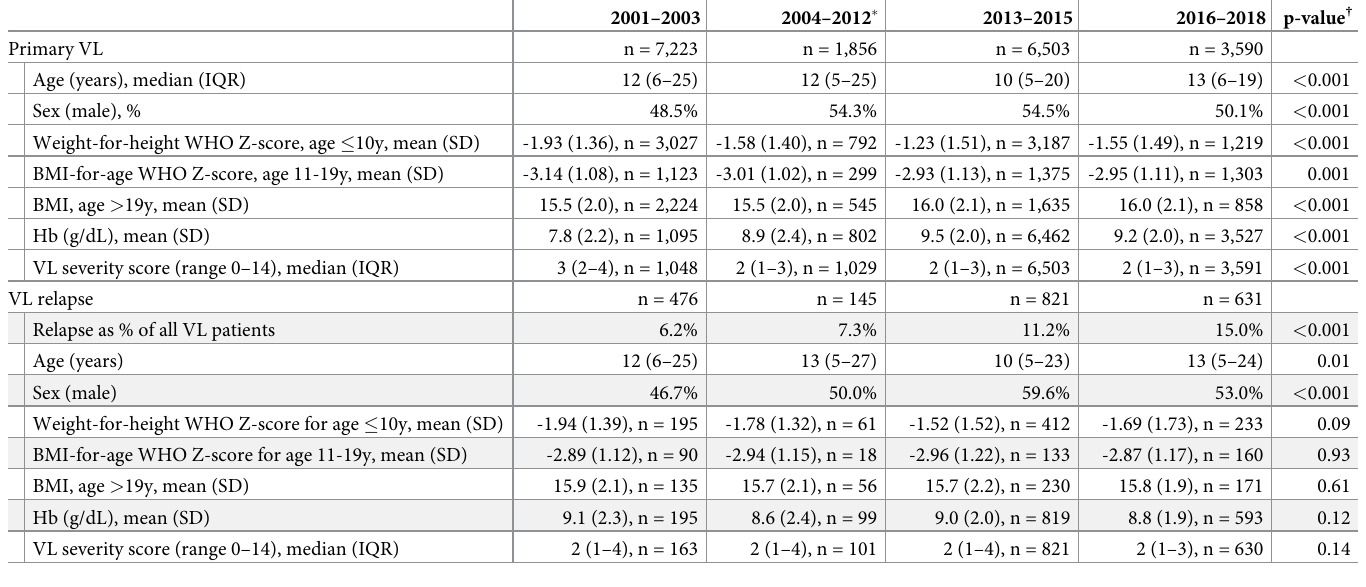
Table 2. Characteristics of primary visceral leishmaniasis (VL) and VL relapse patients treated at Me´decins Sans Fronti è res (MSF) centres in South Sudan, 2001– 2018 (patient-level data on admission).